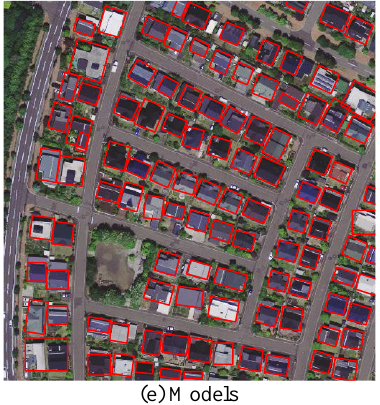
Figure 4 The morphological computation results: (a) reconstructed houses, (b) markers, and (c) masks.